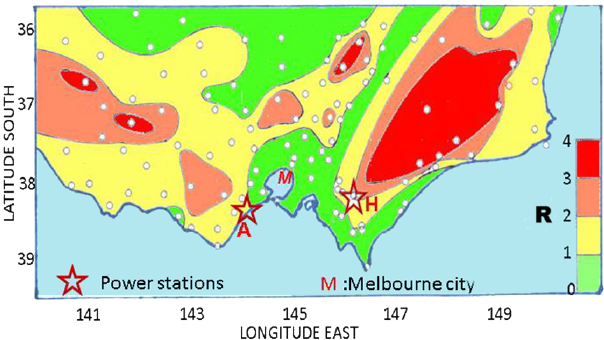
Figure 6. Contours of R (ratio of pre-1960 to post-1960 CD FH ) for the sites in Table 2. Hazelwood (H) and Anglesea (A) power stations are marked with a star, the city of Melbourne with